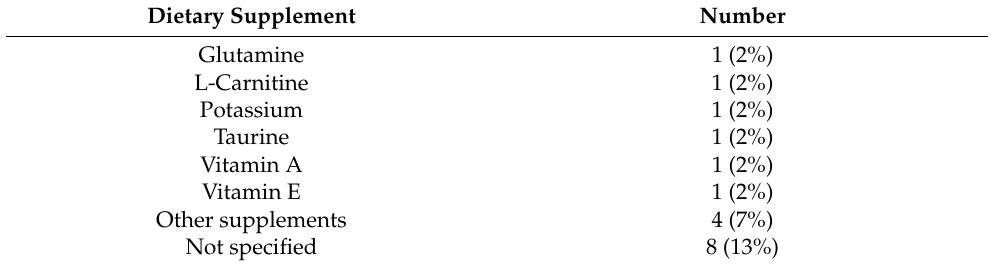
Table 4. Cont . Dietary